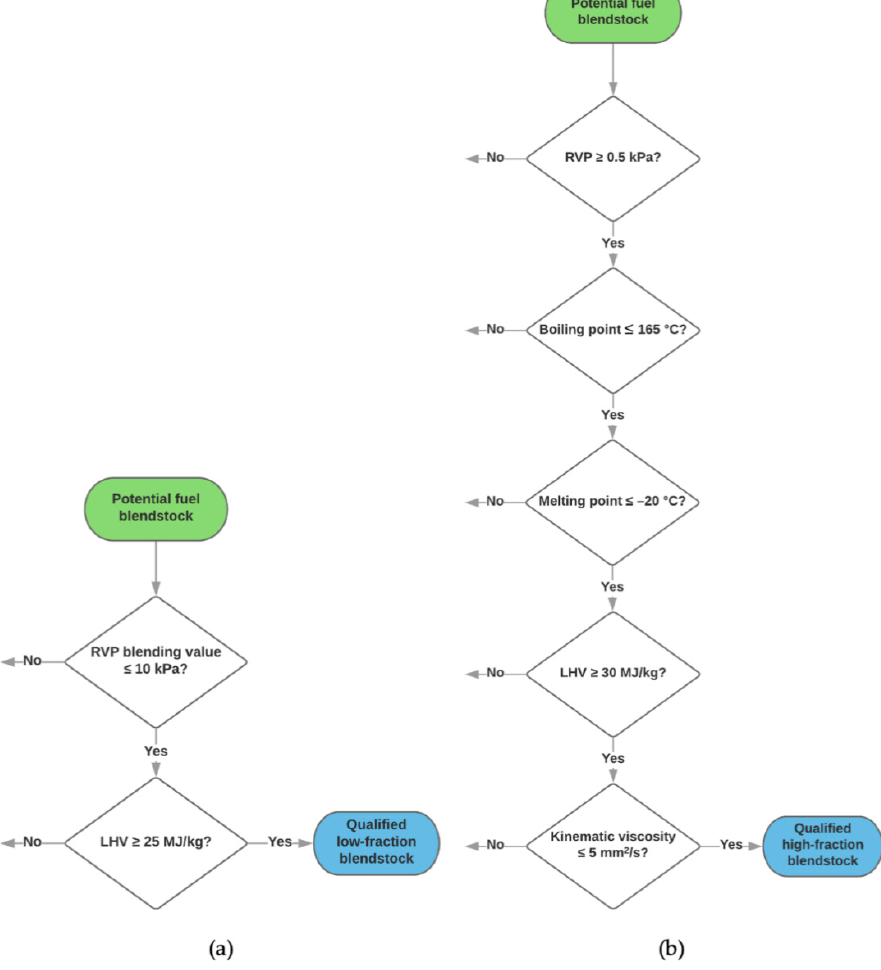
Figure 2. Decision framework for the second-stage screening of the alcohol database. ( a ) Low-range blends (Scenario 1). ( b ) High-range blends (Scenario 2).